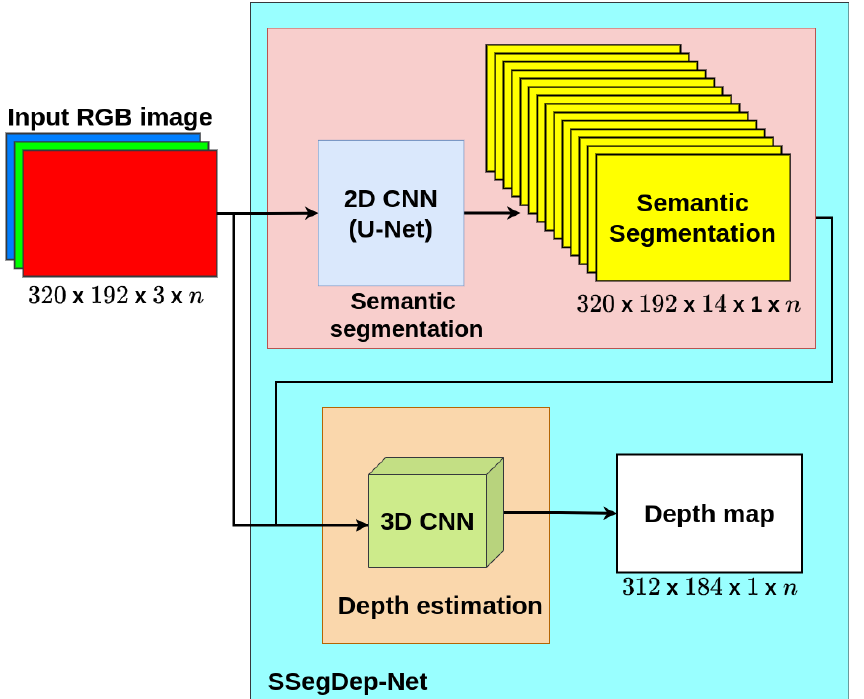
Figure 9. SSegDep-Net